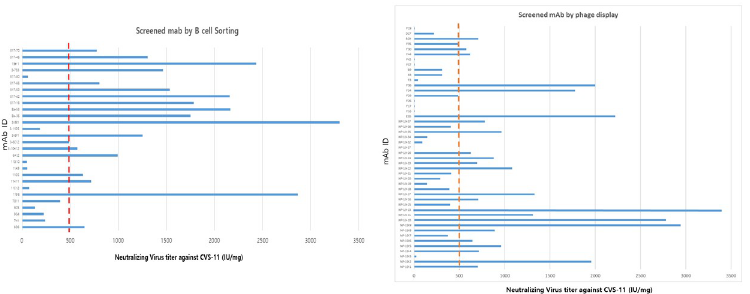
Fig 1. The VNA titers of anti-rabies mAbs. 75 mAbs were tested by VNA activity against CVS-11 and then 28 mAbs were selected with threshold of over 500IU/mg and titer.